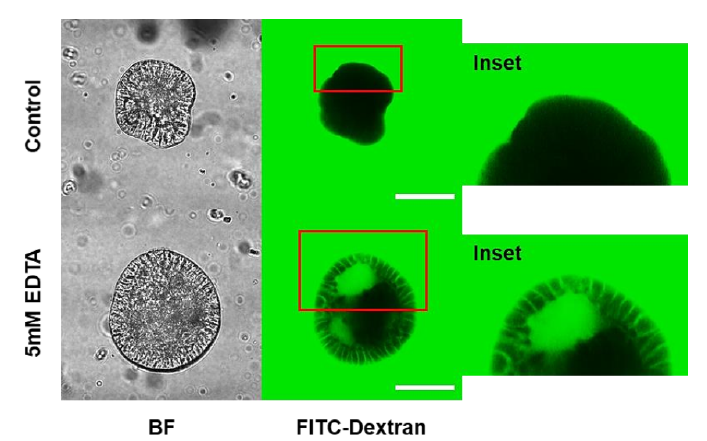
Figure 5. Disrupted gut barrier on porcine small intestinal apical-out organoid. The porcine apical- out organoids were treated in FITC–dextran-containing media (2 mg/mL) (magnification: × 400). Five mM EDTA was used for demonstrating disruption of epithelial barrier integrity. Scale bar (200 µ m). BF, bright